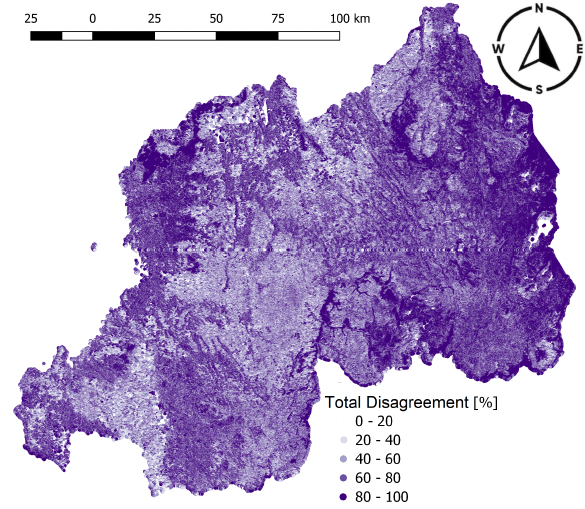
Figure 2. Map of disagreement between GL30 and CCI Africa Prototype